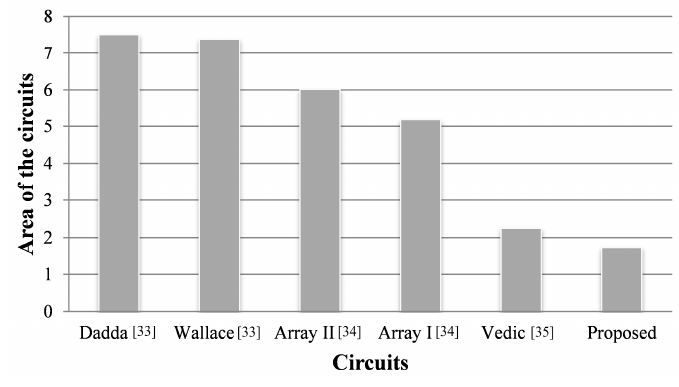
Table 4. Comparison of QCA multipliers.